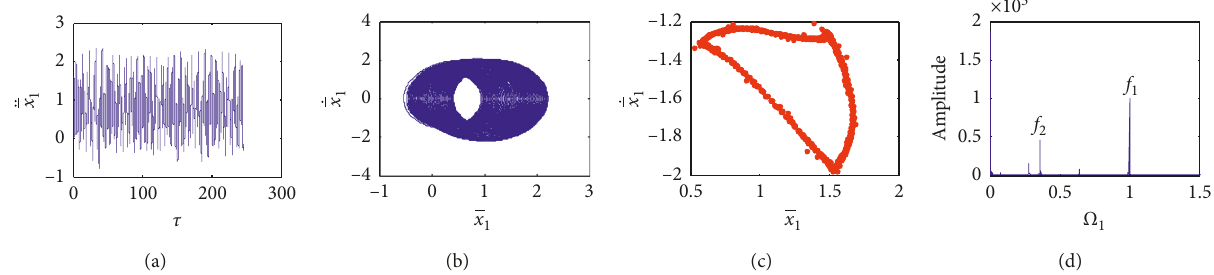
Figure 12: Vibration characteristics when Ω � 2: (a) time domain, (b) phase diagram, (c) Poincar´e section, and (d) frequency domain. 1